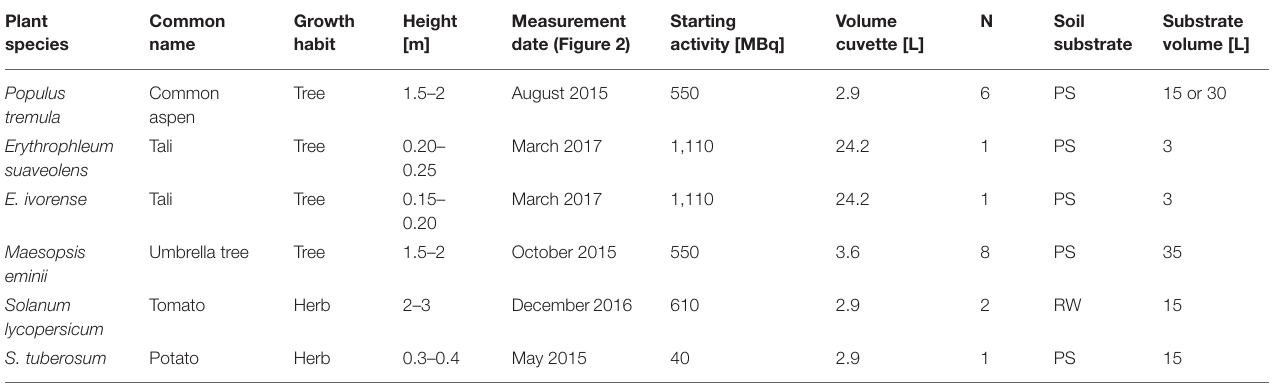
TABLE 1 | Summary of the study species and experimental details. Plant species